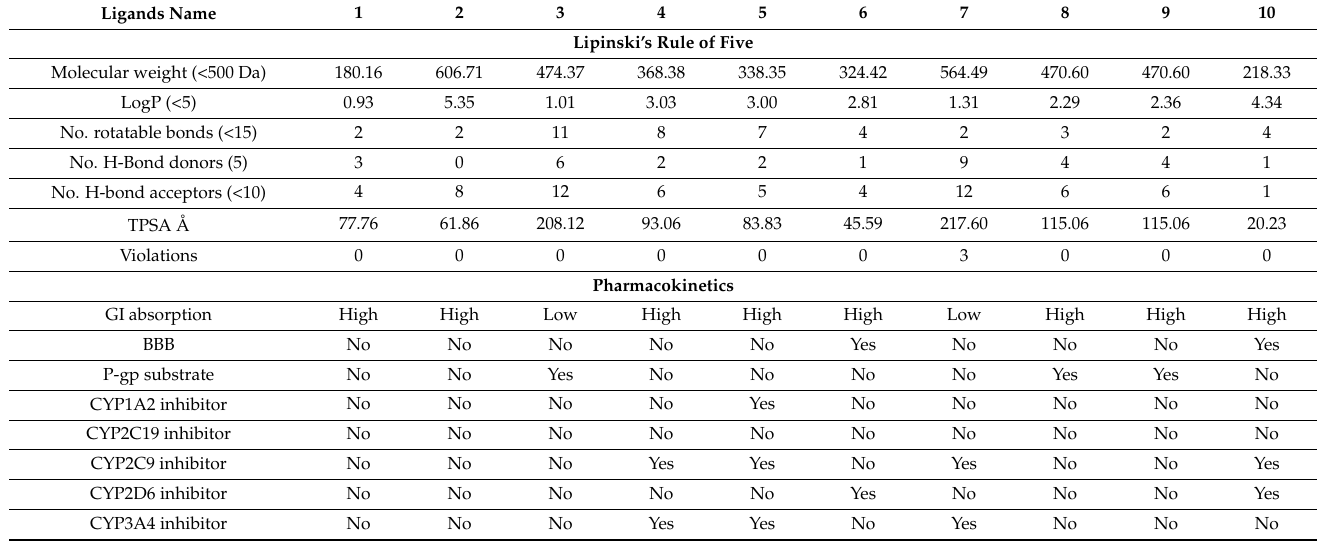
Table 3. Predicted drug likeness and pharmacokinetics of SARS-CoV-2 potential